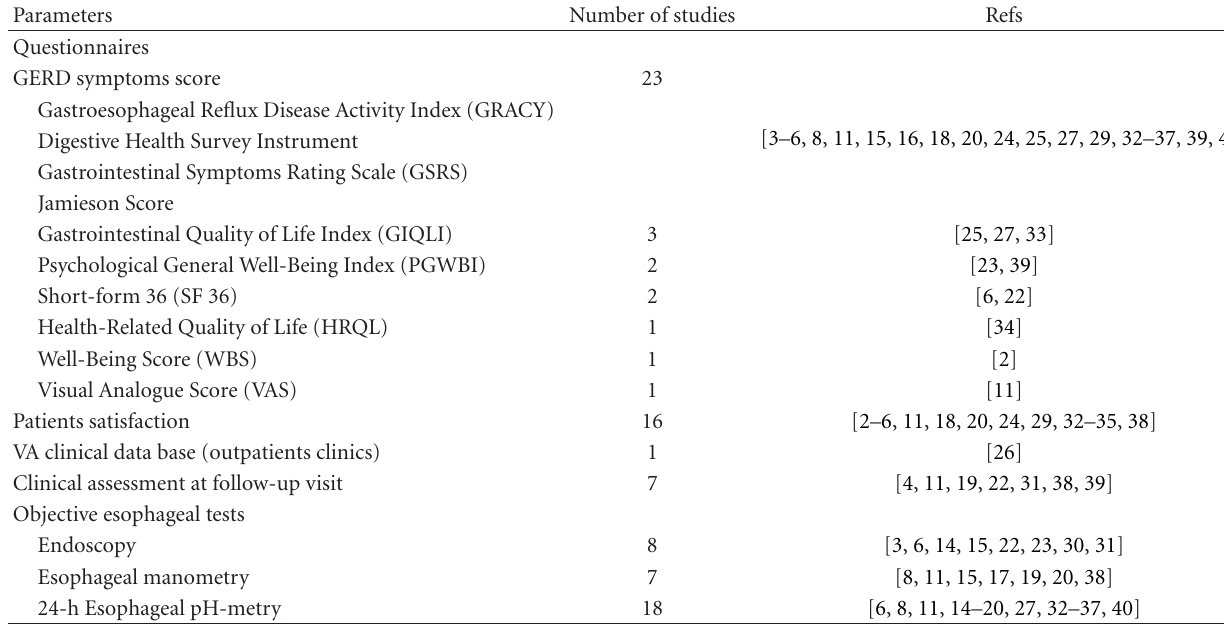
Table 1: Parameters used for patients evaluation and number of studies.